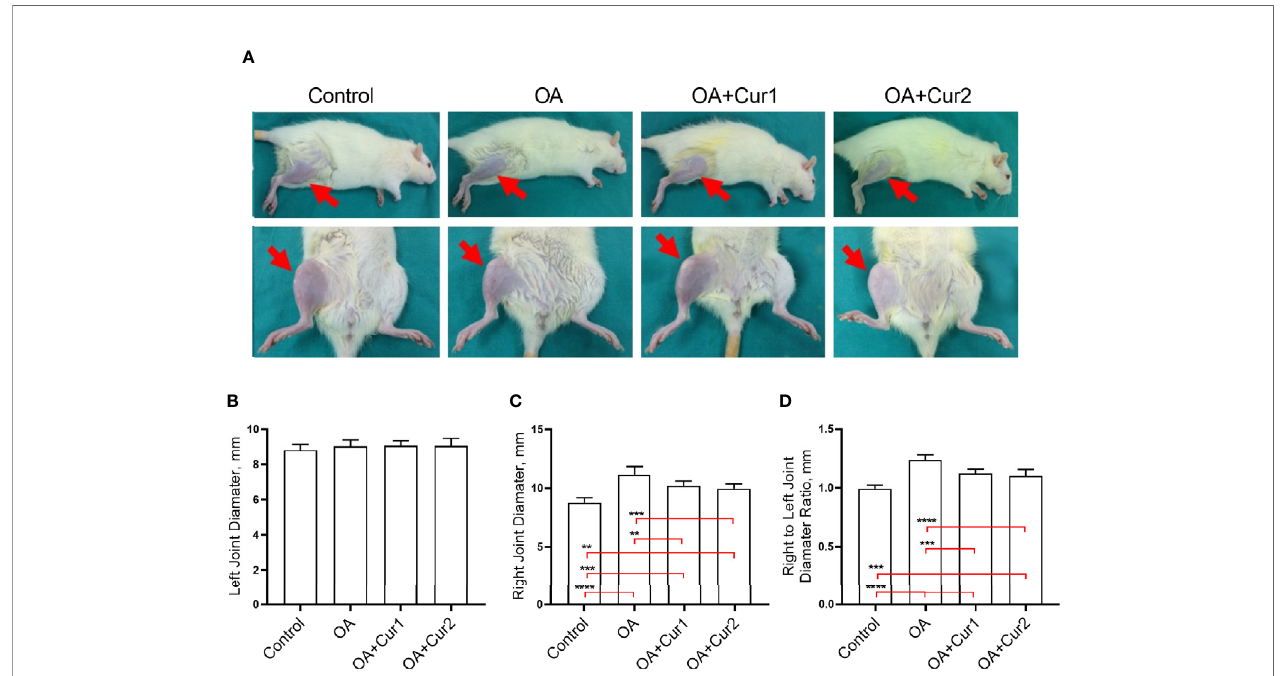
FIGURE 3 | Assessment of the knee swelling in rats with monosodium iodoacetate (MIA)-induced OA after NGUC supplementation. (A) Images of the hind knee joints 4 weeks after Next Generation Ultrasol Curcumin (NGUC) supplementation in rats with MIA-induced OA. Graphs demonstrate (B) left knee joint diameter, (C) right knee joint diameter and (D) the ratio of right to left diameter values in rats with MIA-induced OA. The data are presented as means ± SD (n=7 for each group). Statistical differences among the groups were determined by one-way ANOVA followed by a post-hoc Tukey test; ** p < 0.01, *** p < 0.001, **** p < 0.0001. NGUC, next generation ultrasol curcumin; OA, osteoarthritis; OA+Cur 1, 100 mg/kg of NGUC; OA+Cur 2, 200 mg/kg of